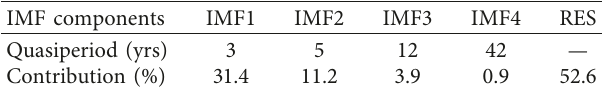
Table 3: Variance contribution rates of IMFs and RES component to Tavg